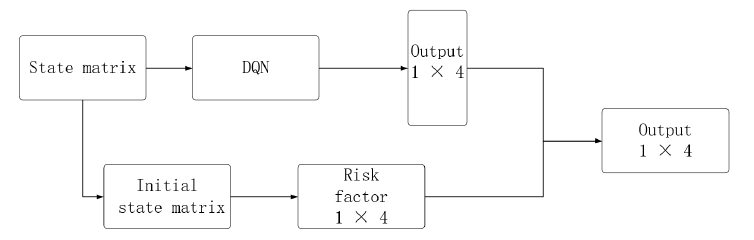
Figure 11. Framework for reducing the probability of choosing a dangerous